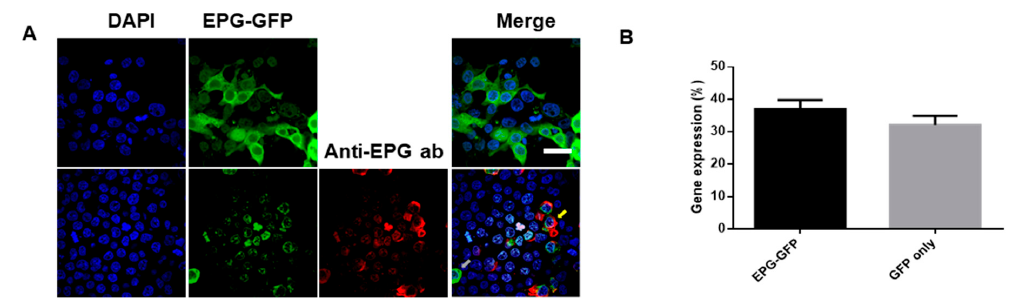
Figure 2. Fluorescence images of EPG expression in HEK293T cells. ( A ) EPG + GFP-transfected HEK293T cells (top images) and immunostaining of EPG + GFP expressed in HEK293T cells (bottom images). Primary antibodies: anti-EPG antibody from a rabbit, secondary antibodies: Alexa 595 conjugated anti-rabbit antibodies from a donkey. Yellow arrow = EPG + GFP with dye-conjugated anti-EPG antibody. Gray arrow = EPG + GFP. (Scale bar = 20 µ m, DAPI, blue: 358⁄461 nm, GFP, green: 475 / 510 nm, Alexa 595, red: 540 / 595 nm). ( B ) Gene expression e ffi ciency test (DNA; 2.5 ng / µ L, Lipofectamine 2000:5 µ L, n = 300). Biomolecules 2020 , 10 , x FOR PEER REVIEW